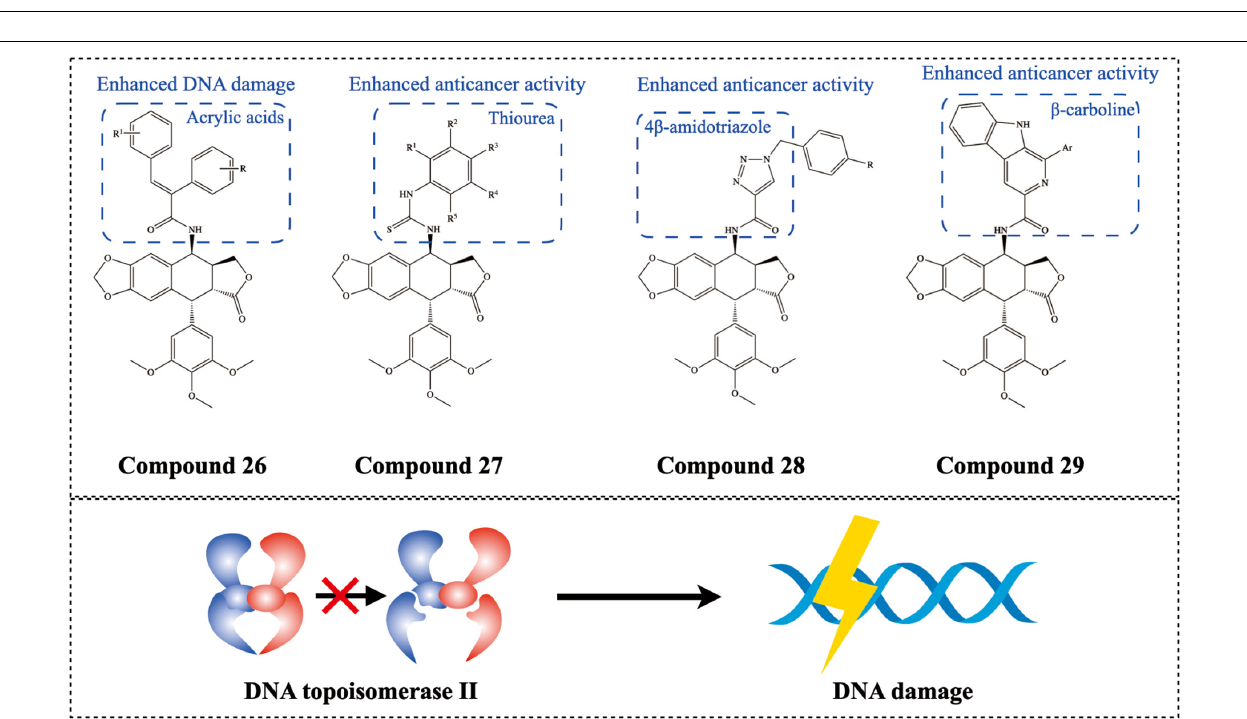
FIGURE 8 | Chemical structures and therapeutic highlights of PTOX derivatives Compound 26–29.